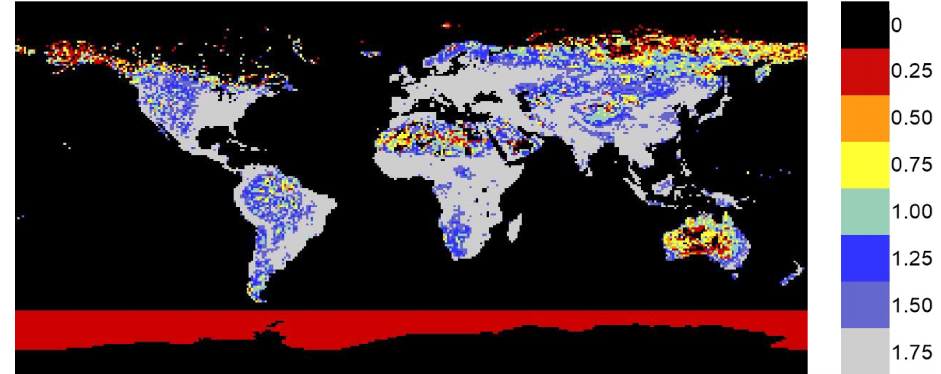
Figure 9. Population map uncertainty assessment example. The plot is for the year 2011 and its key shows the annual uncertainty as a fraction where 1.75 is 175% uncertainty. This map was generated by the average relationship seen in the lower panel of Fig.